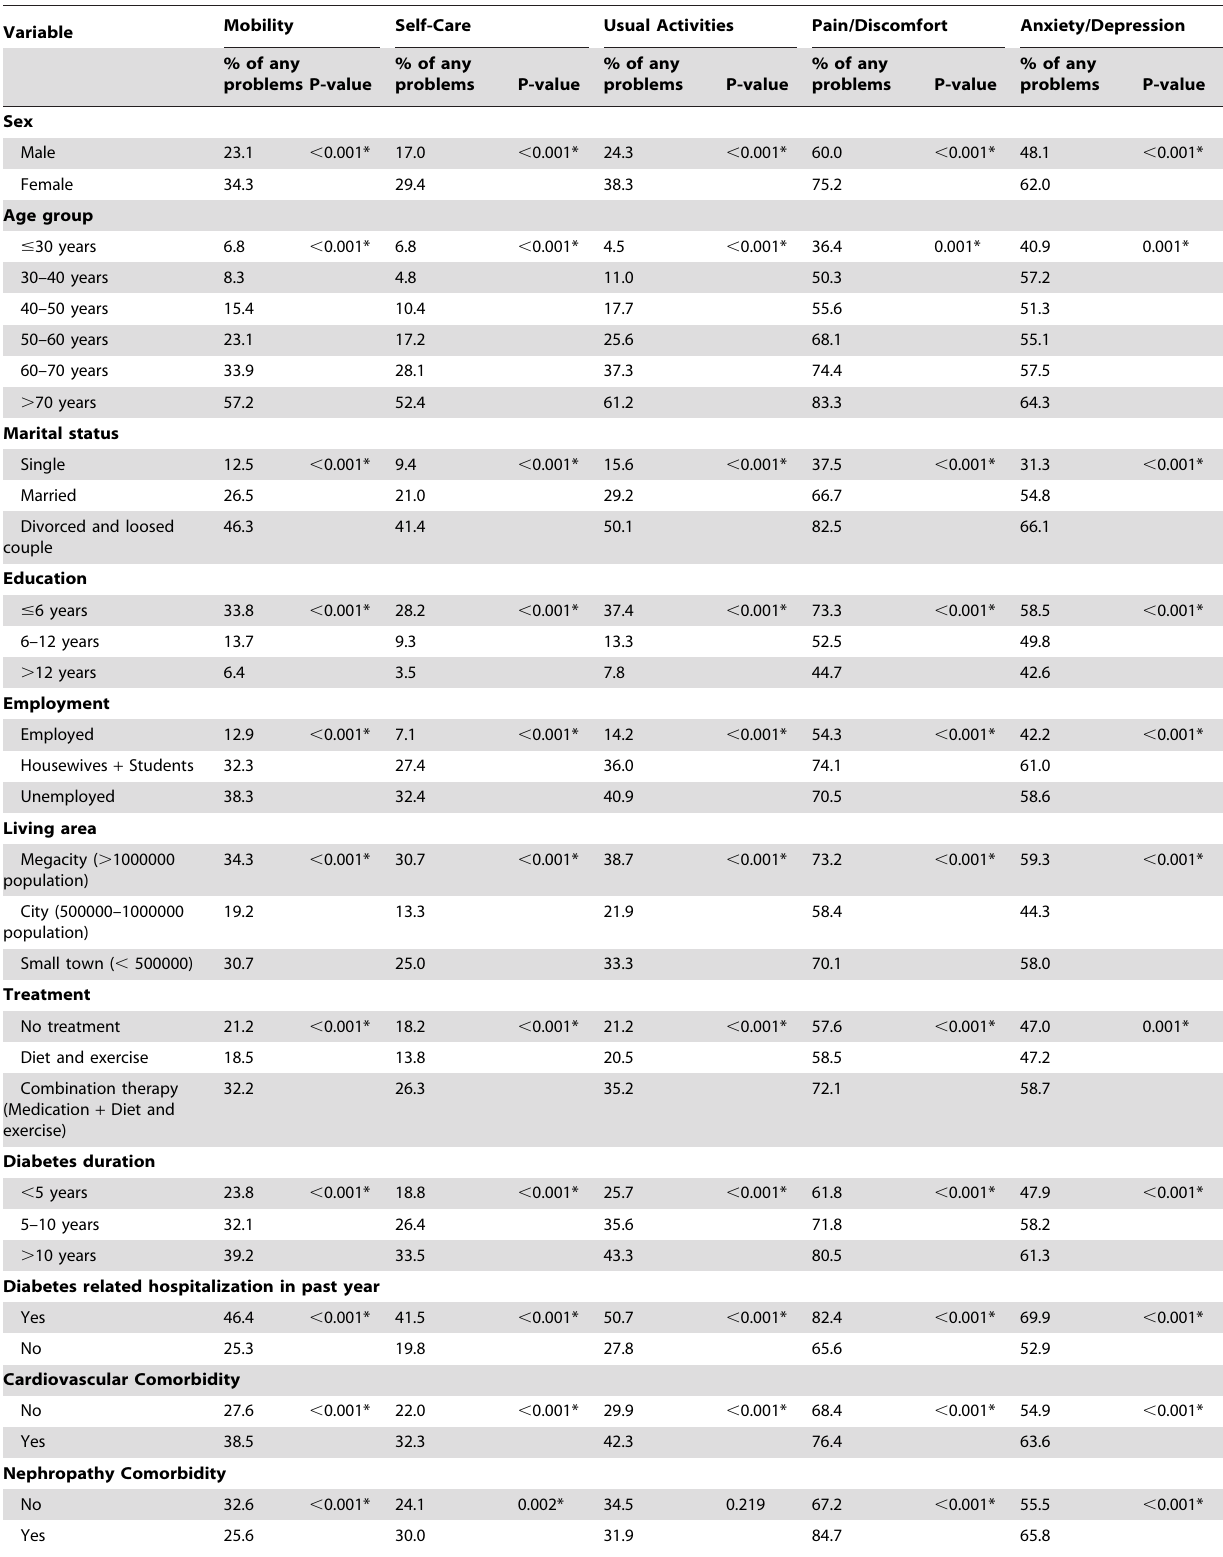
Variable Mobility Self-Care Usual Activities Pain/Discomfort Anxiety/Depression